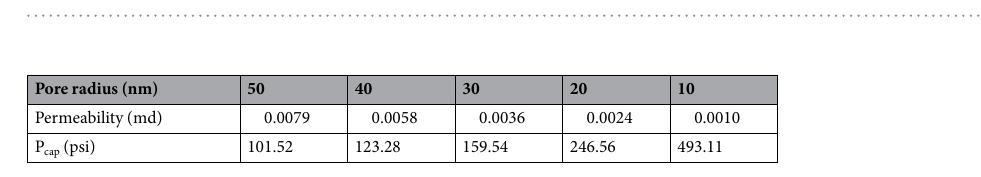
Figure 8. Stress-dependent conductivity multiplier of rock sample from the Bakken